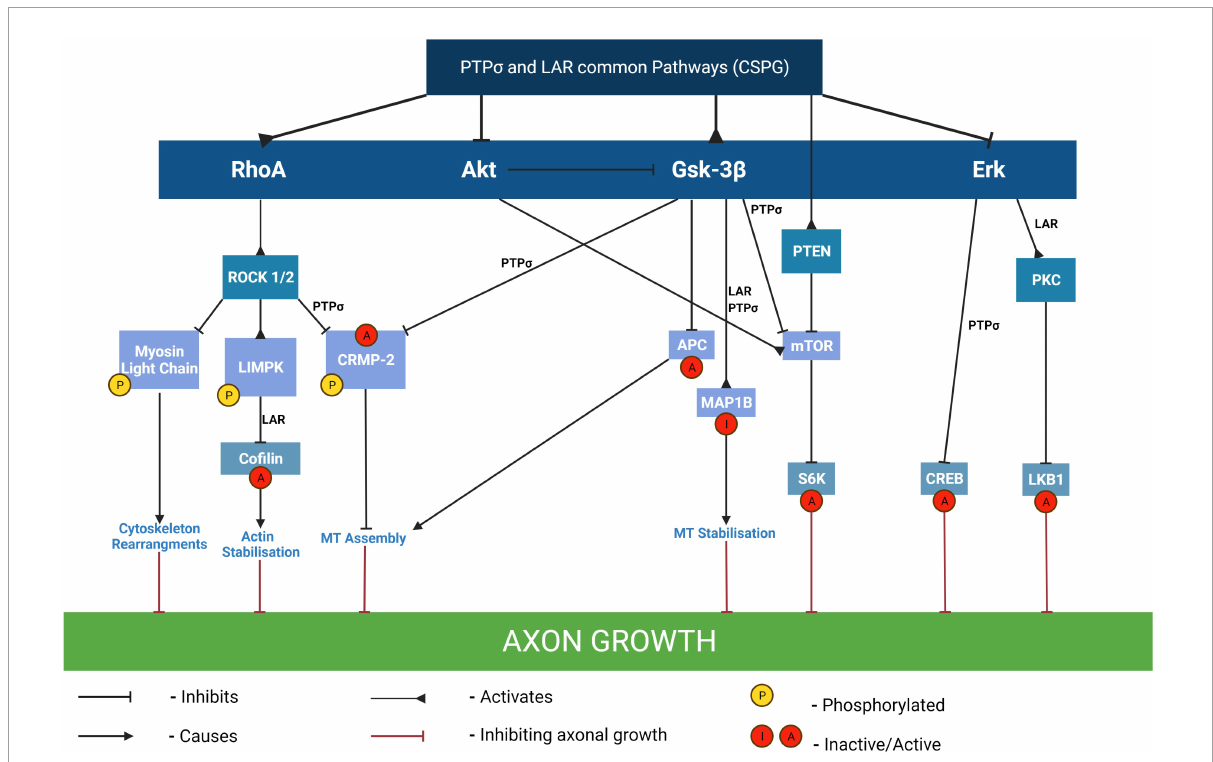
FIGURE5 Pathways mediating the inhibitory effects of CSPGs on axon outgrowth. By binding to either PTP σ or LAR receptors, CSPGs mediate growth inhibition through modulation of several different signaling pathways including activation of RhoA, Gsk-3 β and/or PTEN pathways and/or inhibition of Akt, and/or of Erk pathways. The inactivation of cofilin by phosphorylation results in the stabilization of F-actin and consequent inhibition of neurite outgrowth and is mediated by LAR. In contrast, the inactivation of CRMP-2 and APC which results in inhibition of microtubule assembly with consequent growth inhibition is mediated by PTP σ . The downregulation of Akt and Erk signaling pathways results in inactivation of their downstream targets mTOR/S6 kinase and CREB respectively, which are required for neurite outgrowth. MT, microtubules; LKB1, liver kinase B1 (which plays a role in axon growth initiation and elongation); MAP1B, MT-associated protein 1B (its inhibition results in axon growth inhibition via MT stabilization); CRMP-2, collapsin response mediator protein-2 (this is a MT interacting protein and its inactivation by phosphorylation results in growth cone collapse); APC, adenomatous polyposis coli; PKC, isoform of protein kinase C (involved in the activation of LKB1 and consequent axon growth); CREB, cyclic AMP response element binding protein (phosphorylation of CREB recruits the transcription activator CREB-binding protein to stimulate CRE-related genes involved in the generation of neurites); S6K, S6 kinase (a downstream effector of mTOR involved in protein translation and required for cell growth). Adapted from Sami et al.